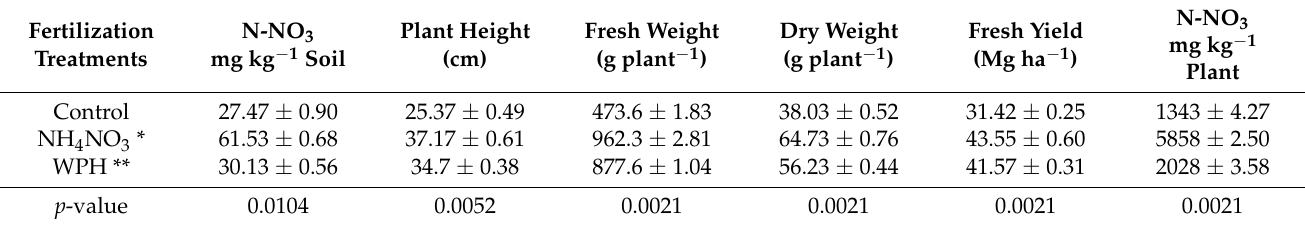
Table 4. Effect of fertilization treatments with NH 4 NO 3 (200 kg N ha − 1 ) and foliar spray with 2000 mg L − 1 . WPH on lettuce content of N-NO 3 (mg kg − 1 plant), growth, and yield traits. Fertilization Treatments